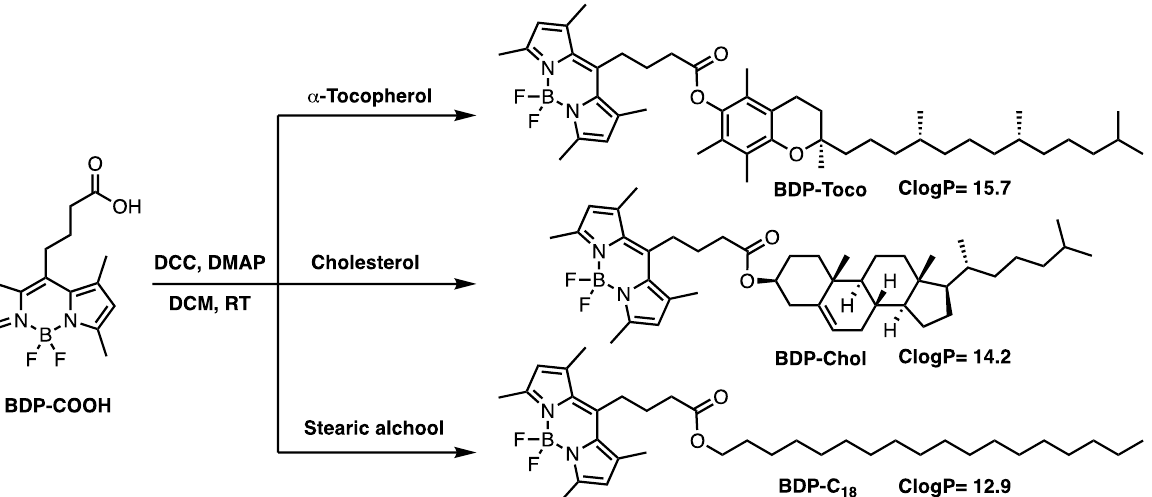
Scheme 1. Synthesis of three natural lipids-BODIPY conjugates from: α-tocopherol: BDP-Toco; cholesterol: BDP-Chol